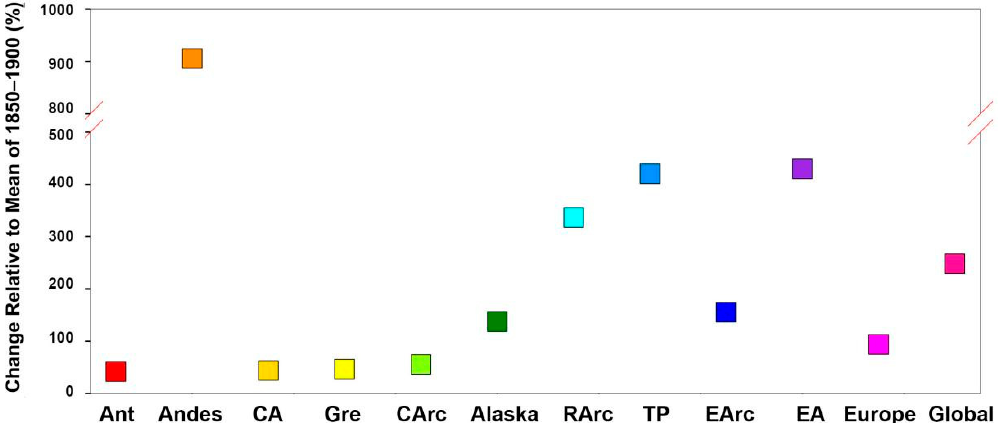
Figure 4. Relative changes in multi-model mean BC concentrations in snow over the period 1850–2014 (1980–2014 mean relative to 1850–1900 mean).